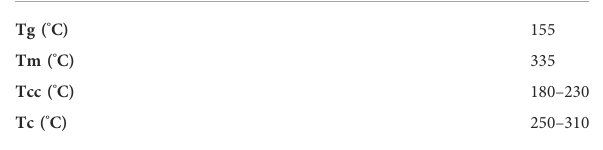
TABLE 1 Characteristic temperatures of PEKK